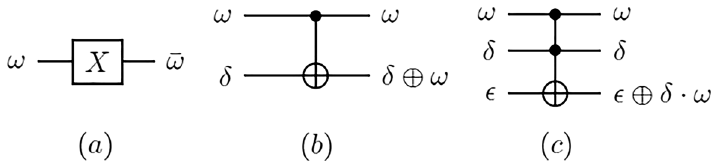
indicates the exclusive logic OR ⊕